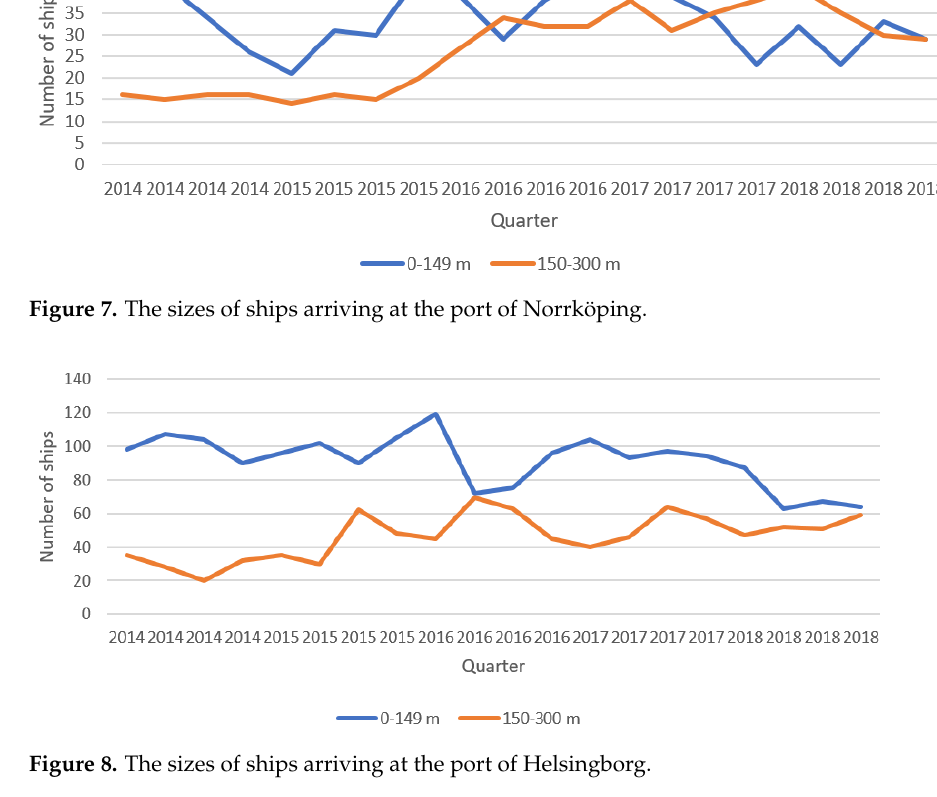
Figure 8. The sizes of ships arriving at the port of Helsingborg.